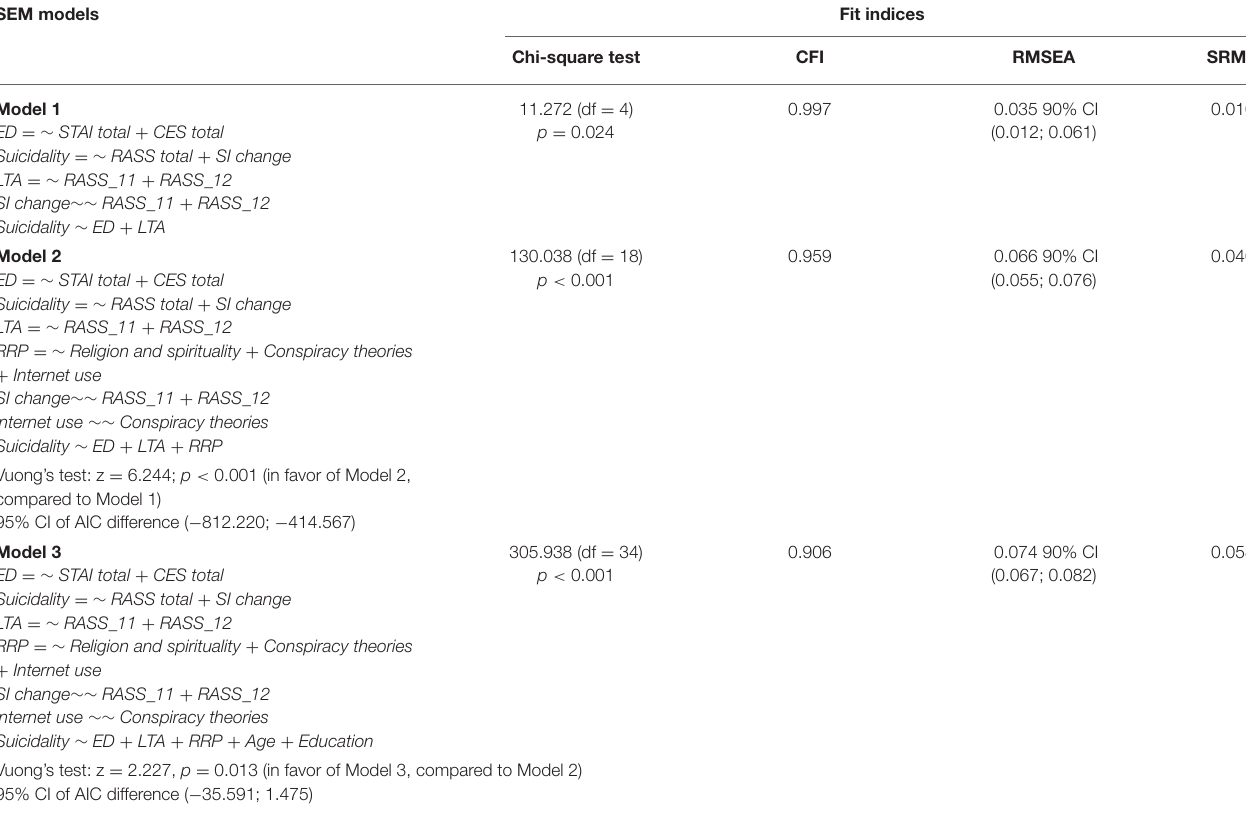
TABLE 6 | The structural equation modeling of the multivariable relationships between the mental health indicators, beliefs and life changes. SEM